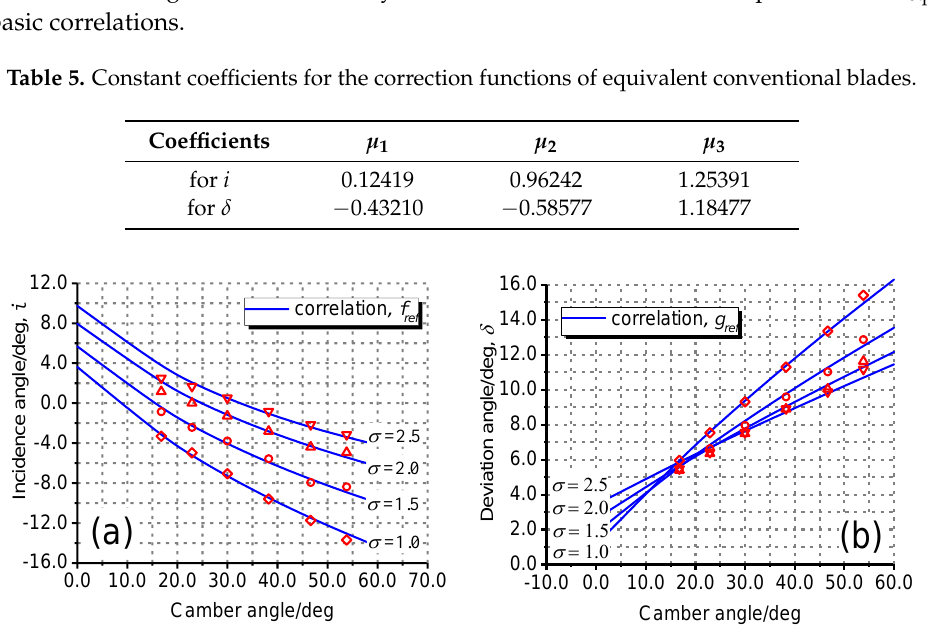
Figure 9. Validations of equivalent ( a ) incidence and ( b ) deviation angles for conventional blade correlations (symbols denote CFD data).